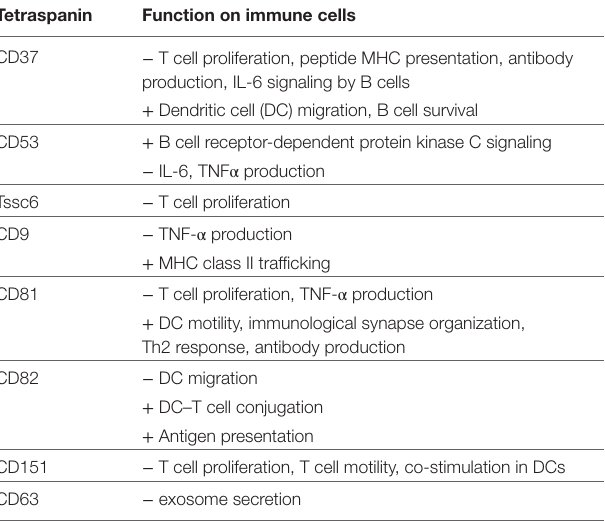
TABLe 1 | Key functions of individual tetraspanins on immune cell subsets.